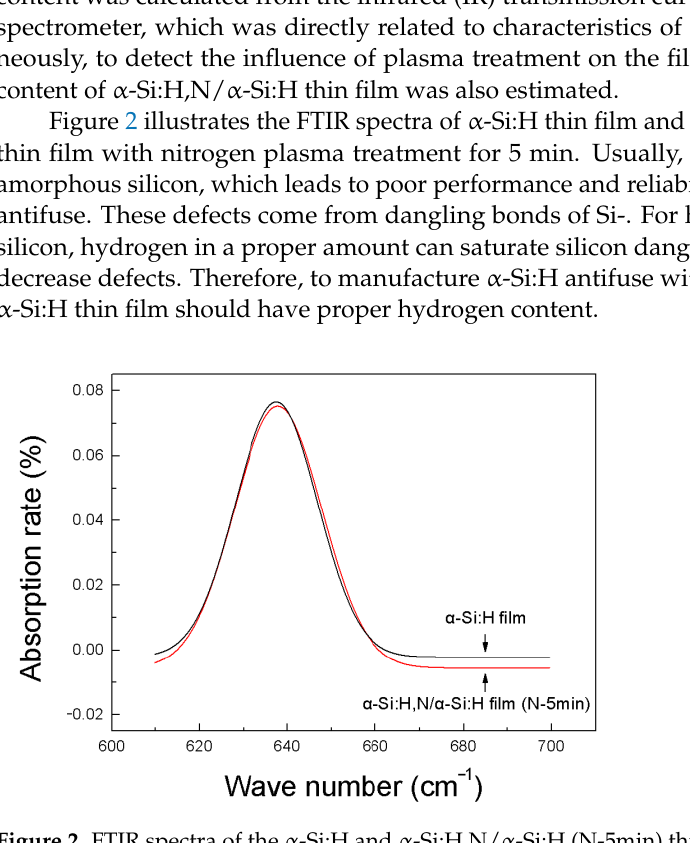
Figure 2. FTIR spectra of the α -Si:H and α - Si:H,N/α -Si:H (N-5min) thin